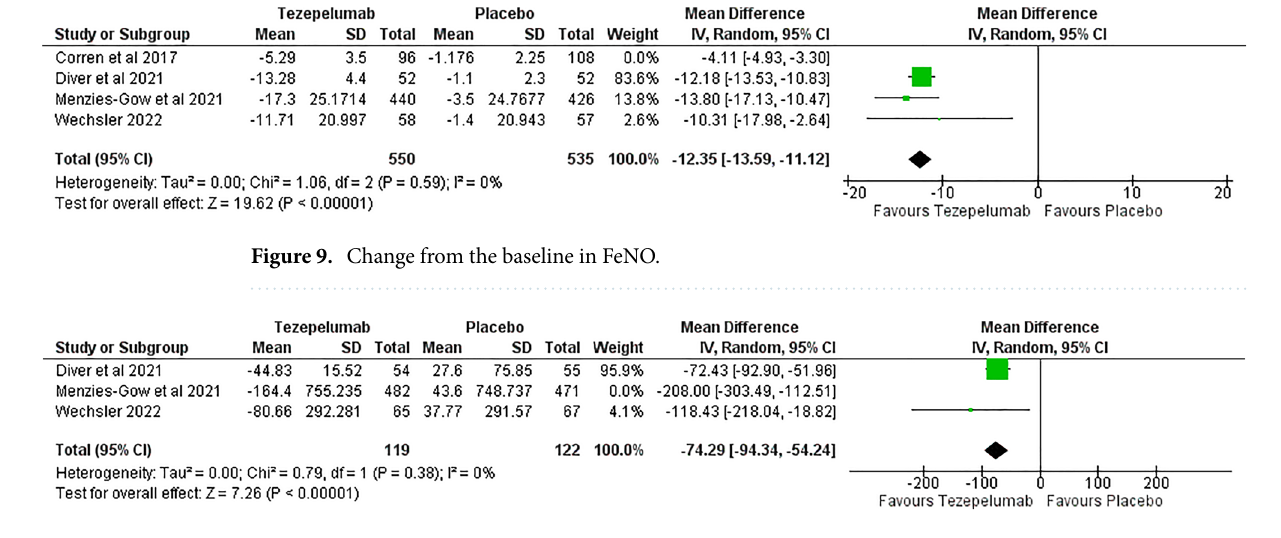
Figure 10. Change from the baseline in Serum IgE.